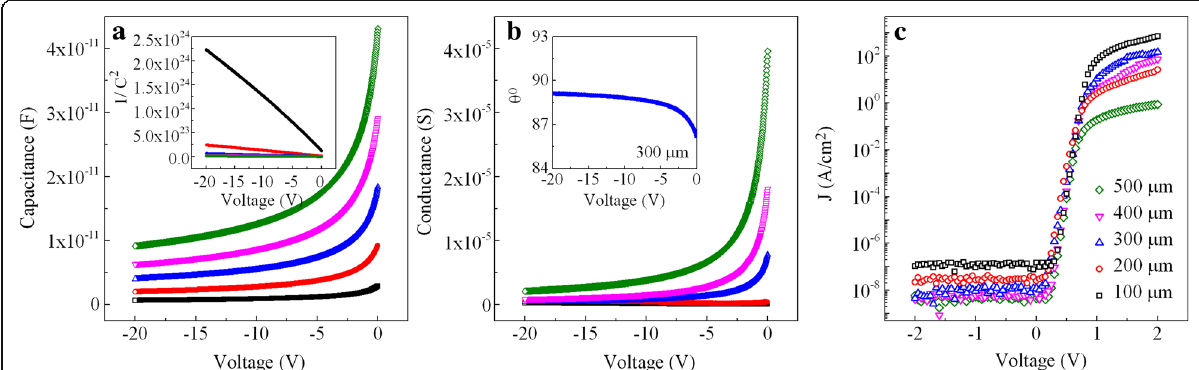
Fig. 2 a Room-temperature C-V curve of vertical SBDs for each different electrode at a frequency of 1 MHz. The inset is a plot of ( 1/C 2 ) versus voltage V . b G-V curve of vertical SBDs for each different electrode. The inset is a plot of phase angle θ versus voltage V for 300- μ m-diameter SBDs. c J-V curve of vertical SBDs for each different electrode